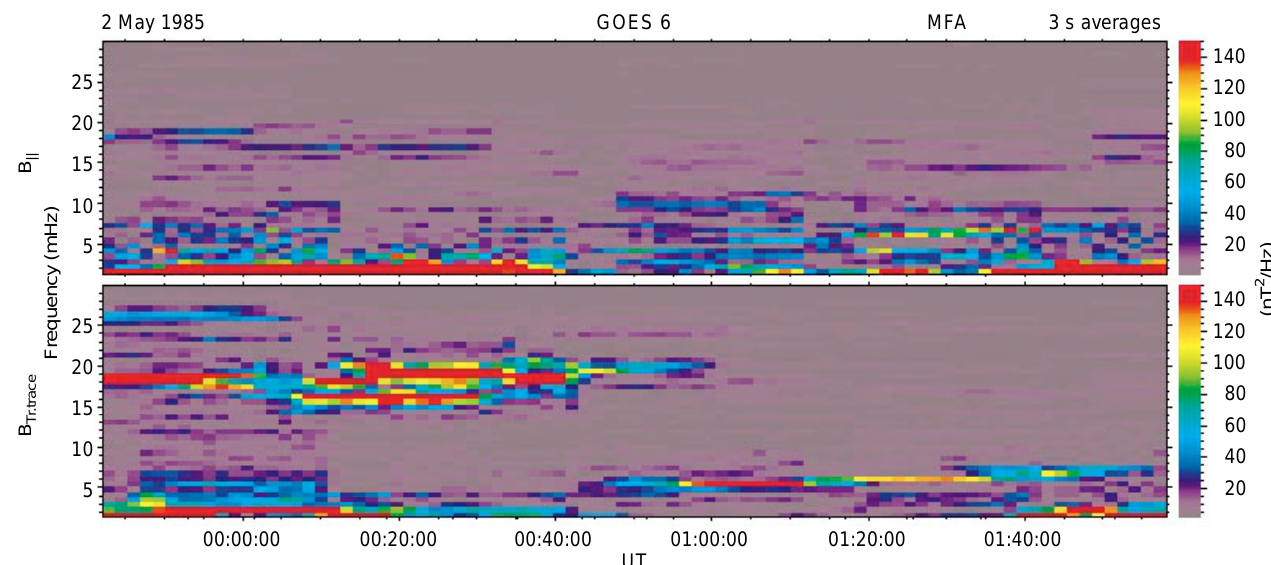
Fig. 2. The dynamic spectra of the parallel and transverse component in a mean field aligned coordinate